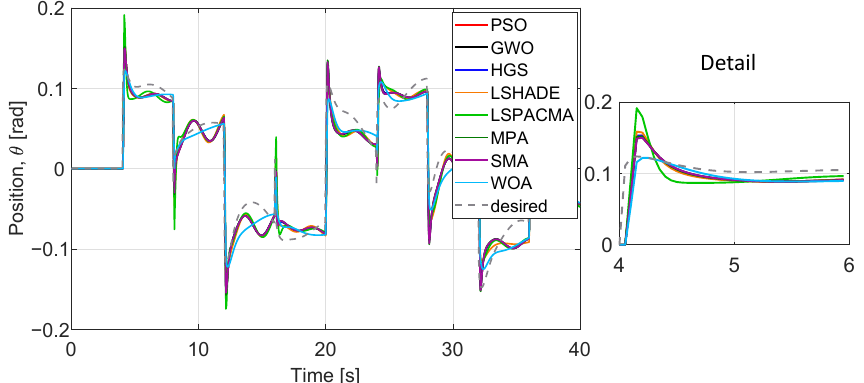
Figure 10. Comparison of tracking performance in θ –angle of the different algorithms evaluating the parameters obtained with 20 individuals.